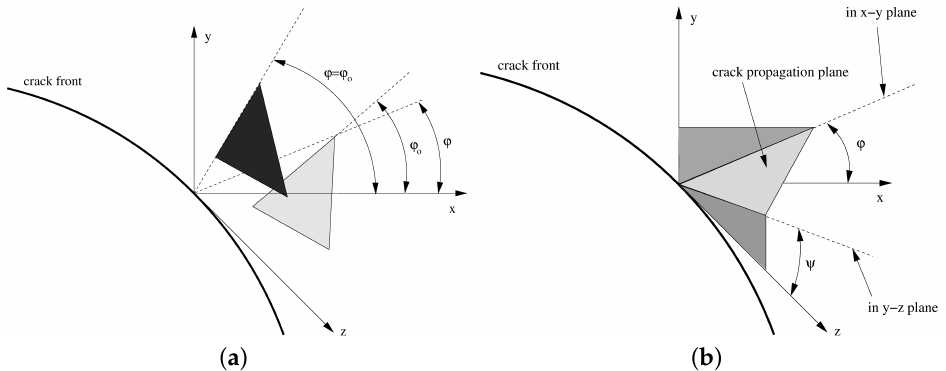
Figure 7. ( a ) Determining the correct deflection angle. ( b ) Deflection and twist angle of the crack propagation